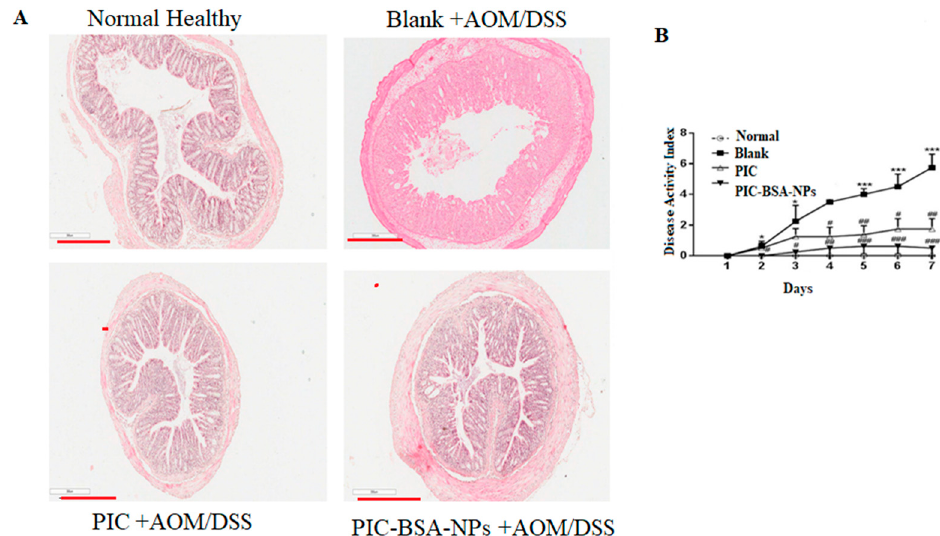
Figure 7. Effect of PIC-loaded albumin nanoparticles on inhibition of experimental colitis. Effect of PIC-loaded albumin NPs and free PIC on azoxymethane/dextran sodium sulphate-induced change in acute colitis ( n = 10 per group). ( A ) Representative hematoxylin and eosin-stained histological sections of control (or negative control), healthy, free PIC, and PIC–BSA NP groups. ( B ) PI–BSA NPs prevent colitis, expressed as disease activity index. Data from the control (or negative control) group are all zeros from day 1 to day 14.